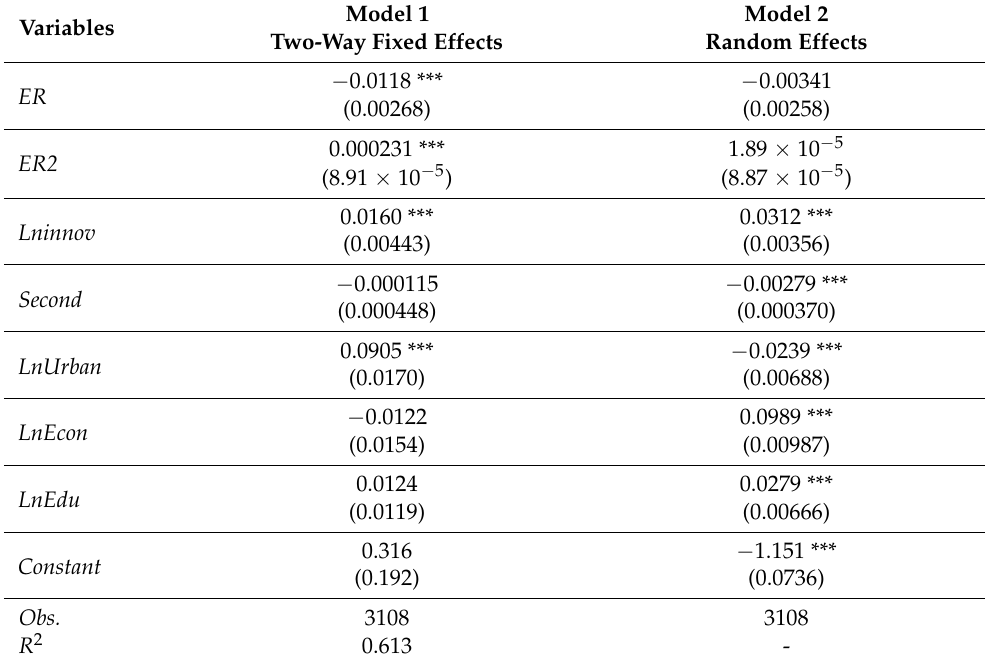
Table 3. Results of fixed effects and random effects